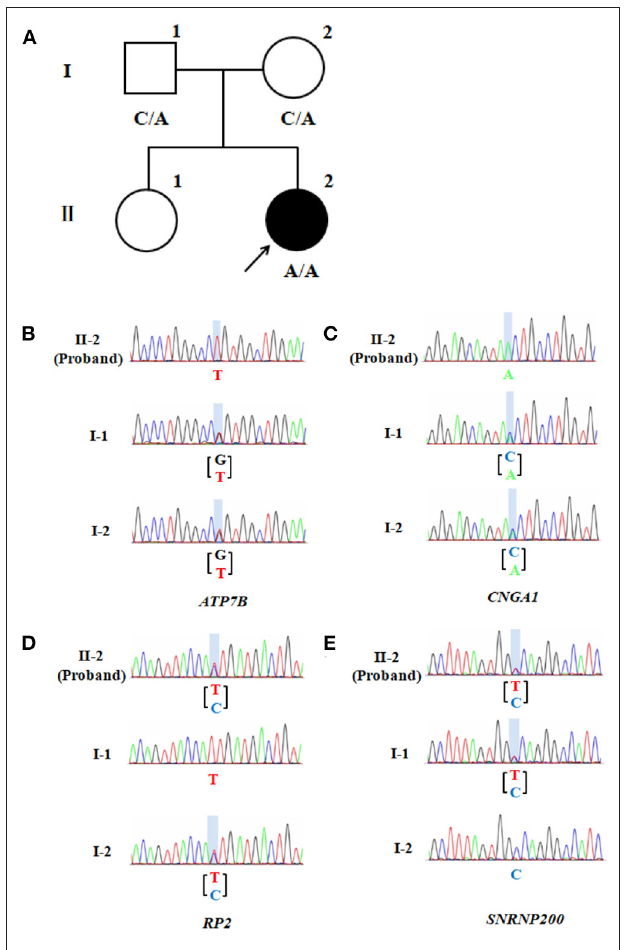
FIGURE 2 | Pedigree of the patient’s family. (A) CNGA1 variant family pedigree. Circles represent females and the square represents the male. The filled circle represents the patient with RP. The proband is indicated by a black arrow, while A represents a mutation. (B) Partial sequence of ATP7B gene locus of the proband (II-2) and the unaffected family members (I-1 and I-2). The columnar graphics indicate the site of the variant. (C) Partial sequence of the family’s CNGA1 gene locus. (D) Partial sequence of the family’s RP2 gene locus. (E) Partial sequence of the family’s SNRNP200 gene locus.